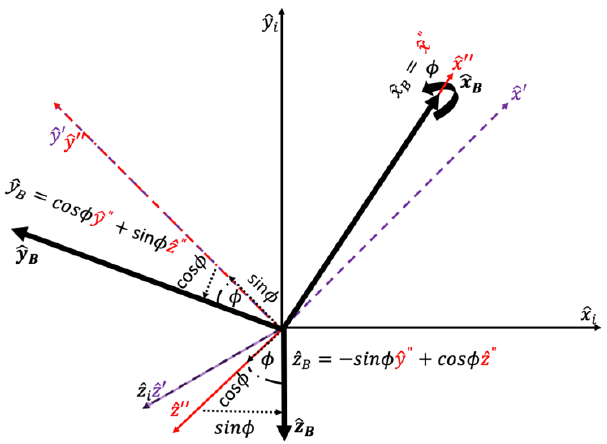
Figure 4. 3-rotation about the x′′̂ and 𝑥 𝑏 ̂ axes [23].